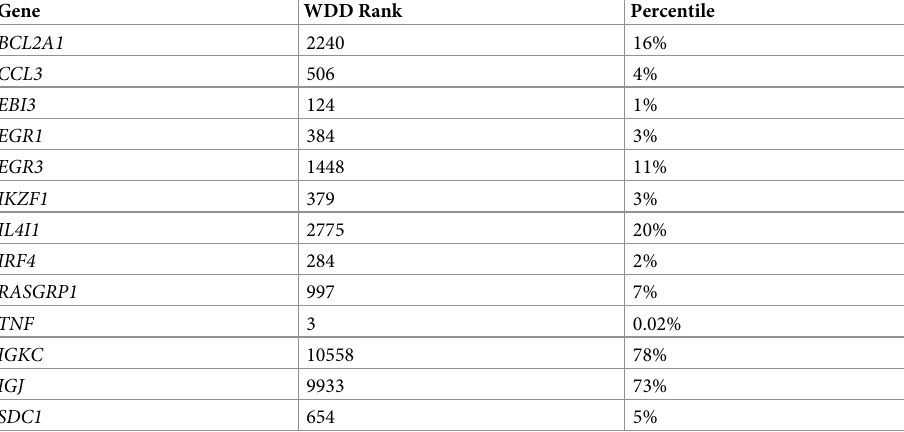
Table 3. WDD matrix factorization ranking of known BTK